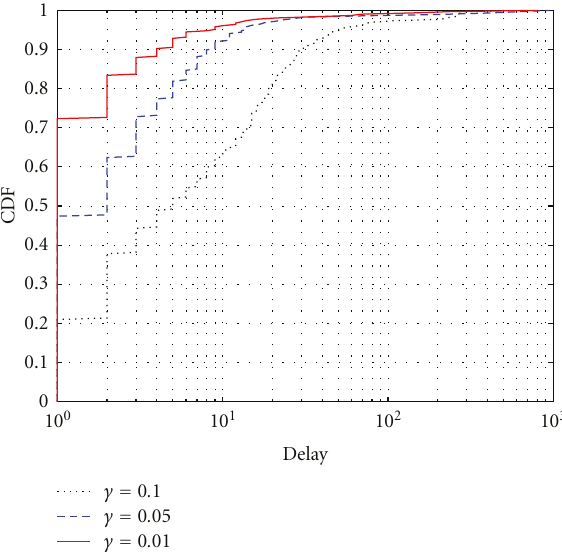
Figure 12: CDF of learning delay with di ff erent temperature γ when N = 2 and system state is fully